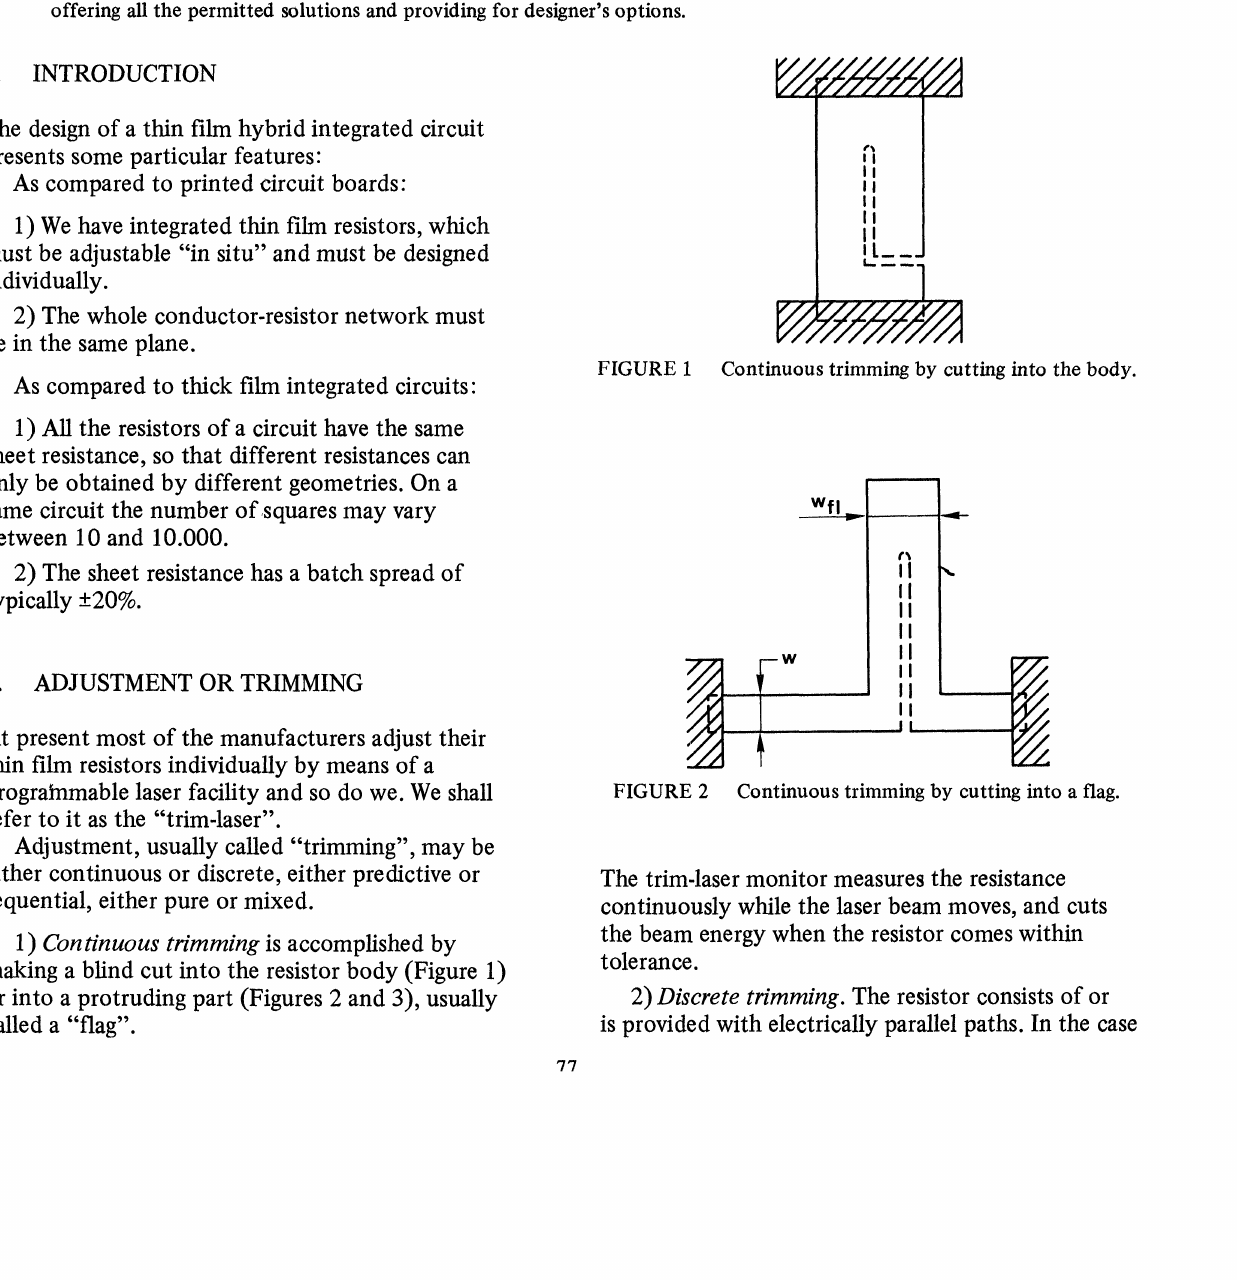
FIGURE Continuous trimming by cutting into the body.